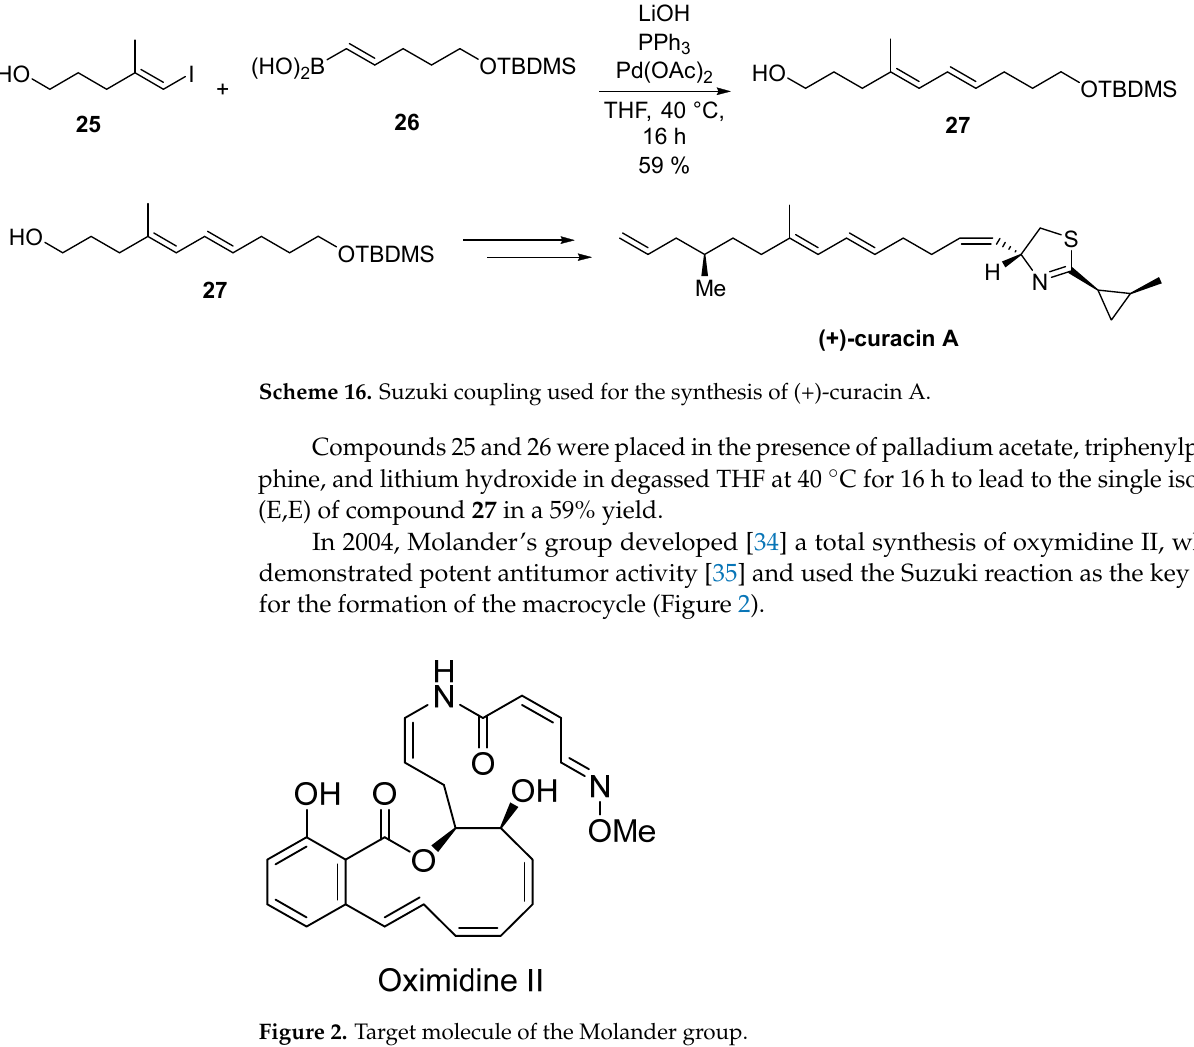
Figure 2. Target molecule of the Molander group.